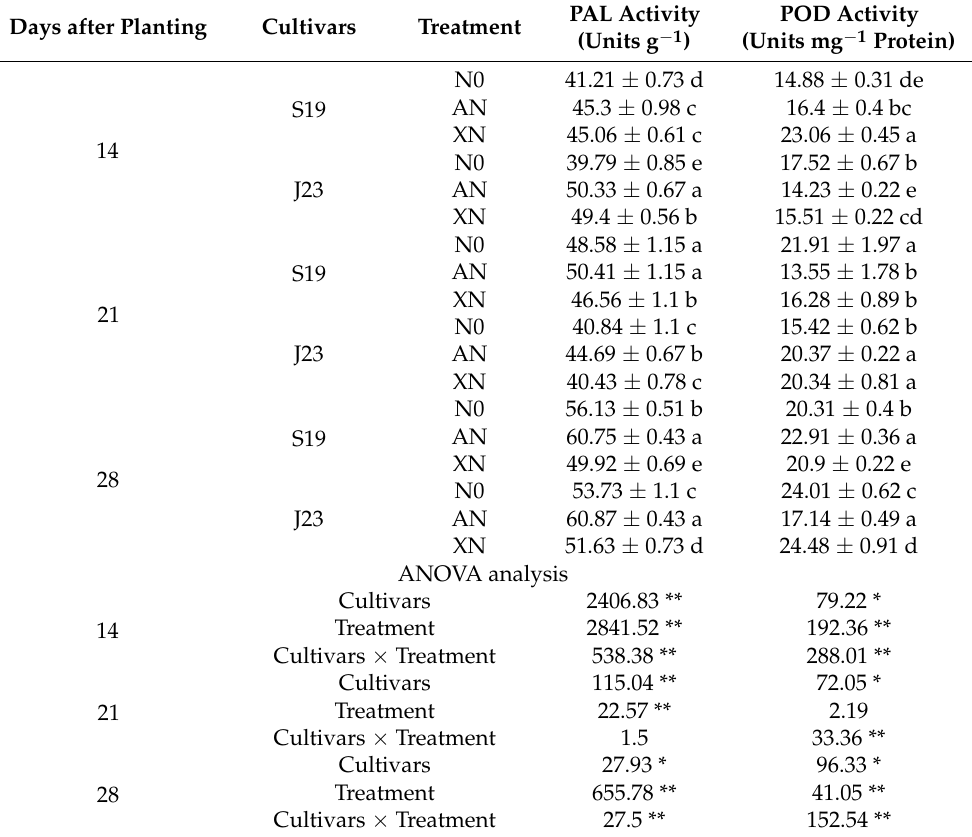
Table 3. PAL and POD activity in potential storage roots of sweet potato during storage root for- mation.